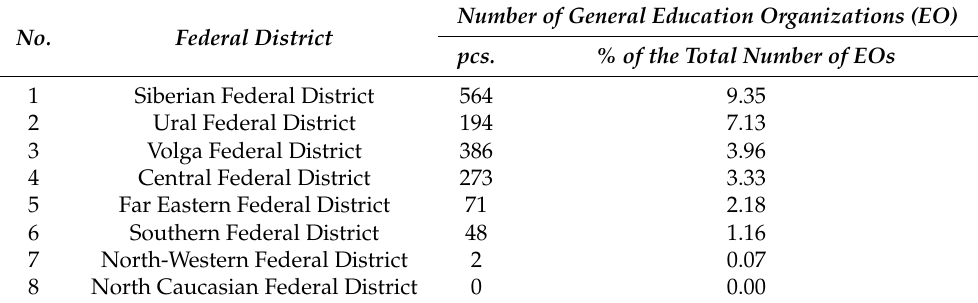
Table 3. The number of general education institutions in federal districts of the Russian Federation using resources for automated meal selections by children and their parents (legal